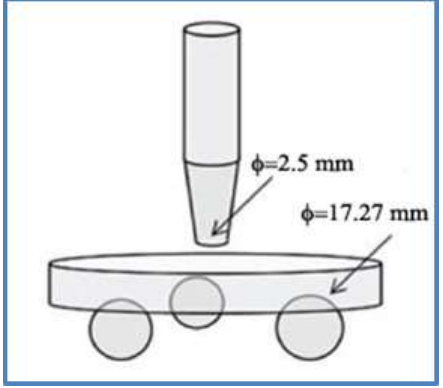
Figure 1: Piston-on-three ball biaxial flexural strength test.